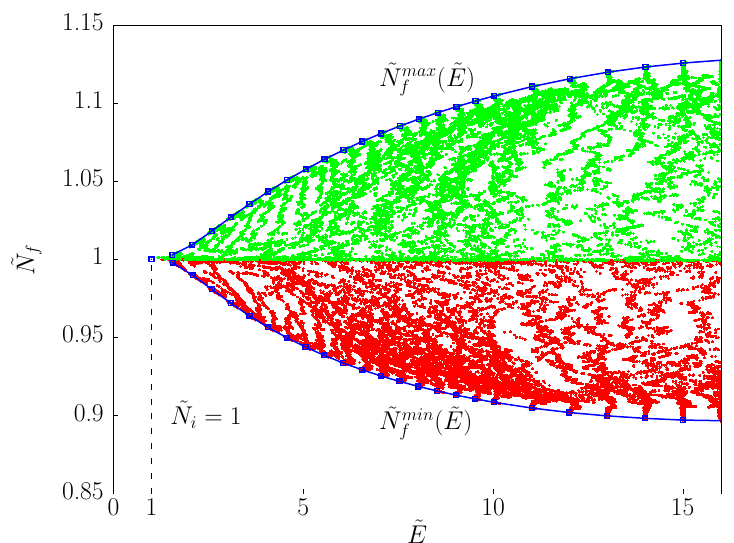
Figure 1 . The results of stochastic sampling for ~ N i = 1, N r = 400 and R = 20. Each dot in the (cid:12)gure represents a classical solution with an energy ~ E and (cid:12)nal particle number ~ N f obtained using the Monte-Carlo technique described in the text. Red (dark) and green (gray) points correspond to positive and negative values of (cid:12) and (cid:24) , respectively. The dashed line marks the threshold energy ~ E = ~ N f = ~ N i (cid:17) 1. The upper and lower boundaries, ~ N max solid